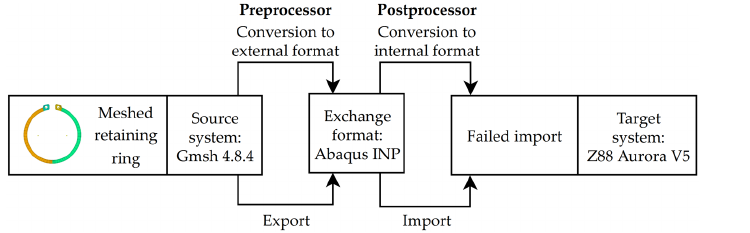
Figure 11. Failed data exchange of a retaining ring model between the finite element mesh generator Gmsh and FEM software Z88.